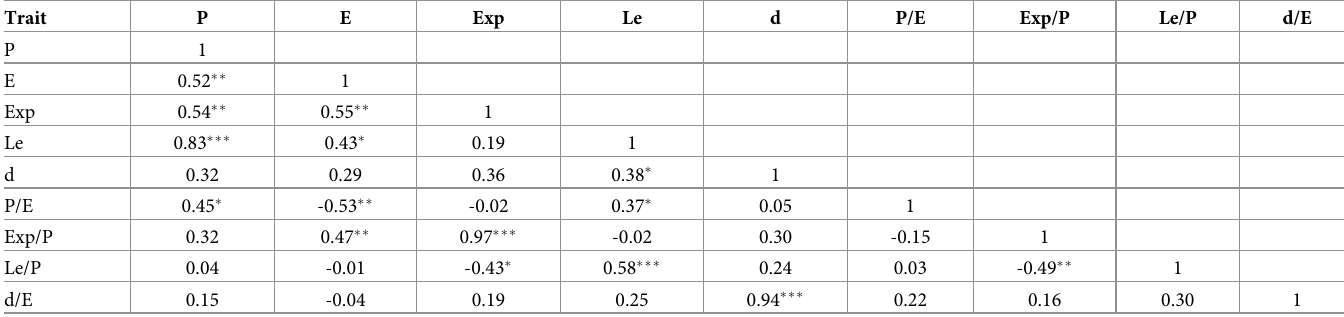
Table 5. Correlation coefficients between observed features.